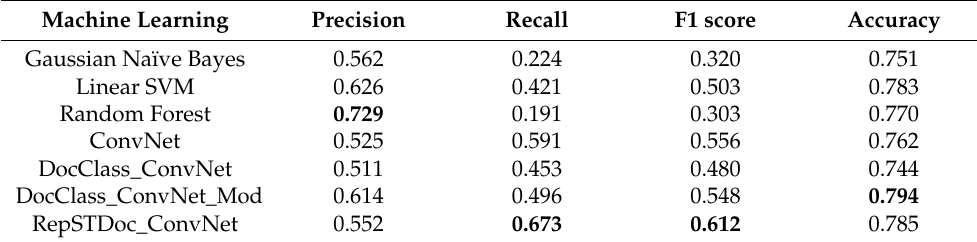
Table 4. Comparison of evaluation based on the precision, recall, F1 score, and accuracy.